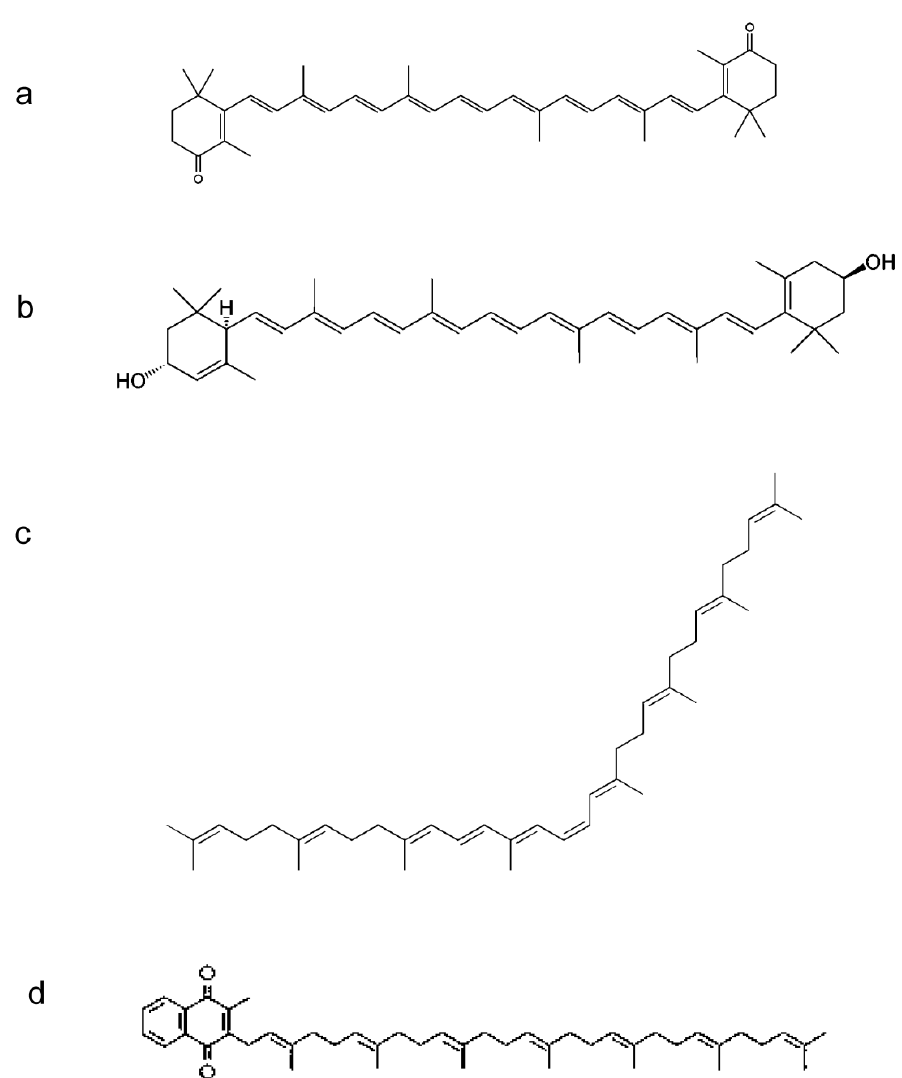
Figure 4. Chemical structures of: ( a ) canthaxanthin, ( b ) lutein, ( c ) phytofluene, and ( d ) menaquinone-7.